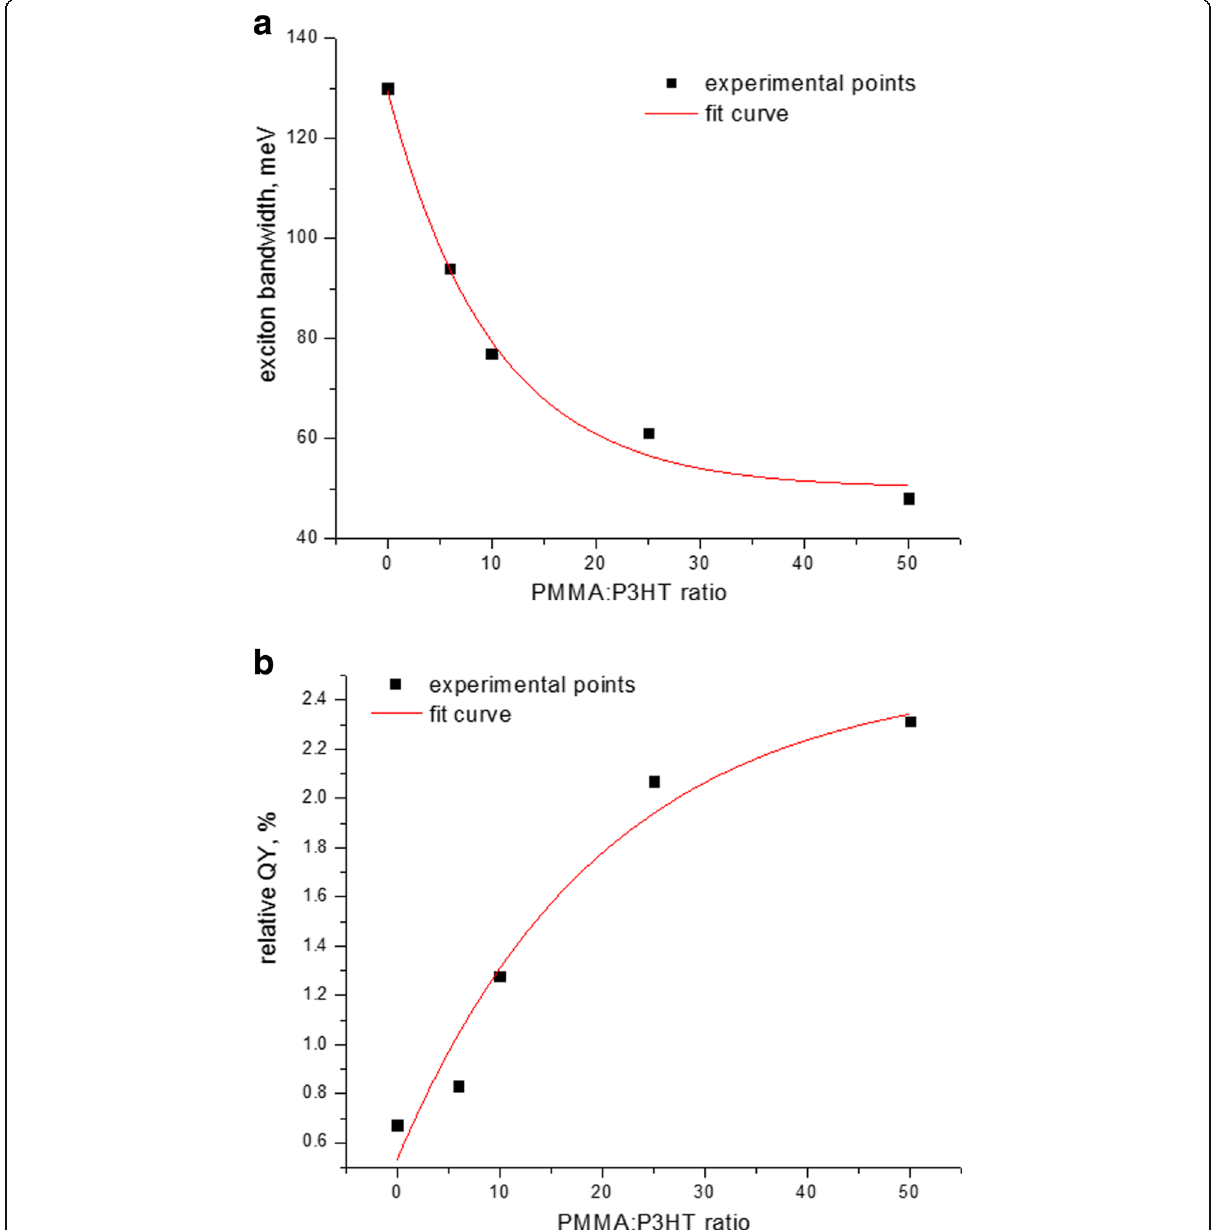
Fig. 2 a Exciton bandwidth and b relative QY of emission of P3HT-PMMA composite films as a function of PMMA:P3HT weight ratio, assuming that the QY for the neat P3HT film is about 0.5%